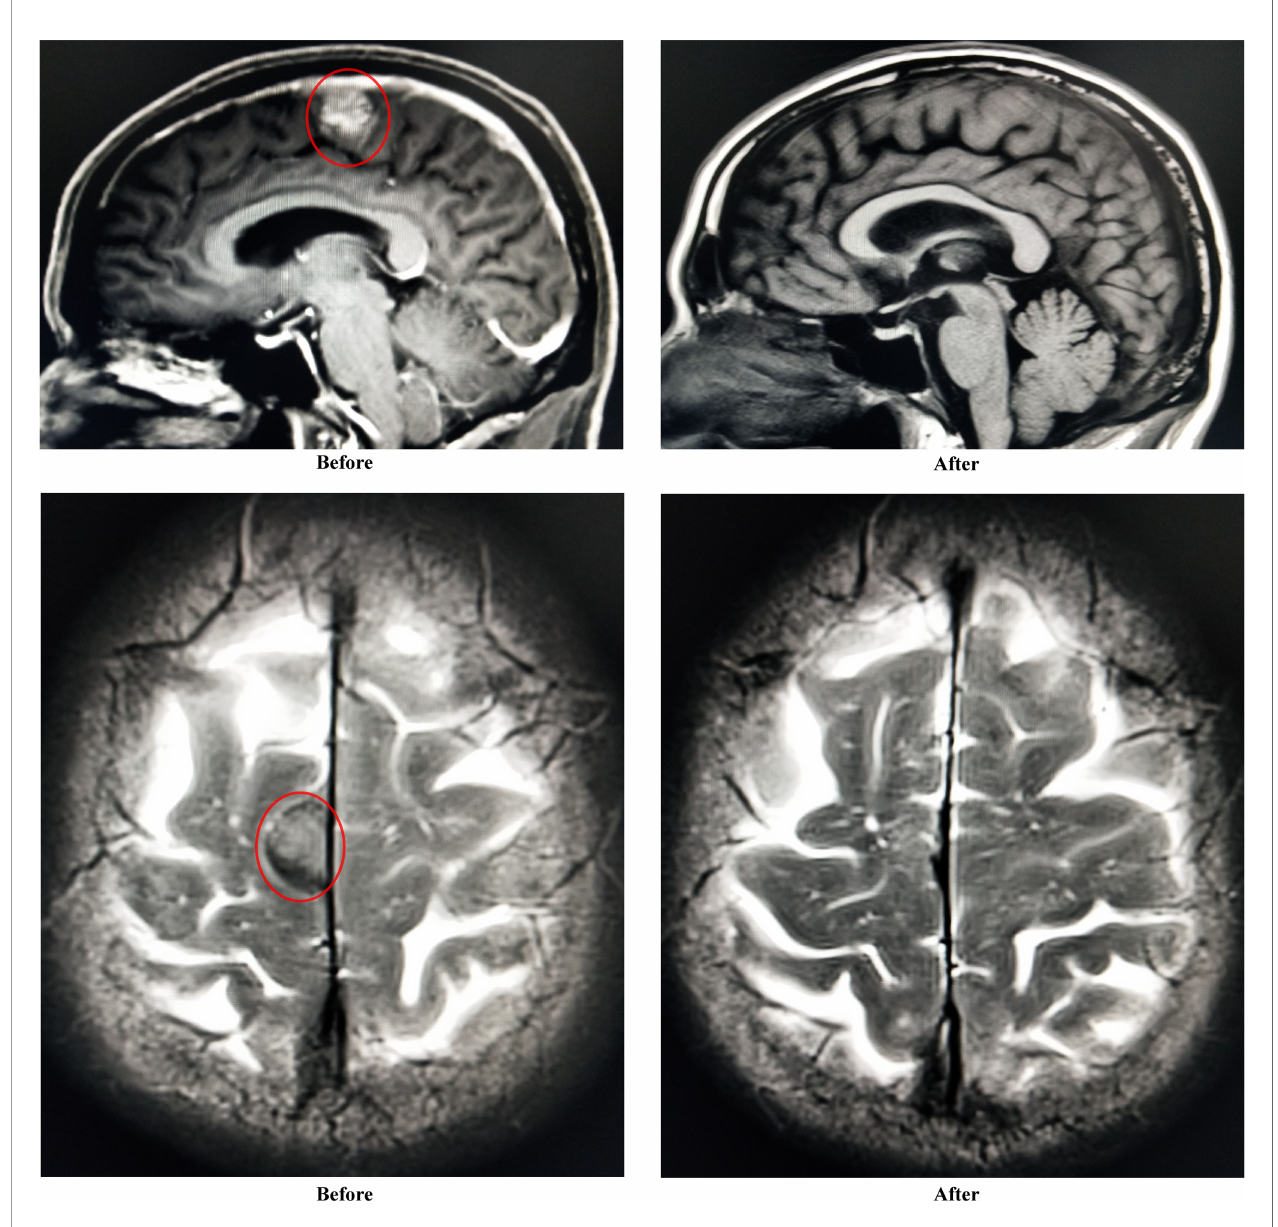
FIGURE 4 | Improvement of abnormal signals in right parietal lobe region (sagittal plane and transverse plane) before and after CAR-T